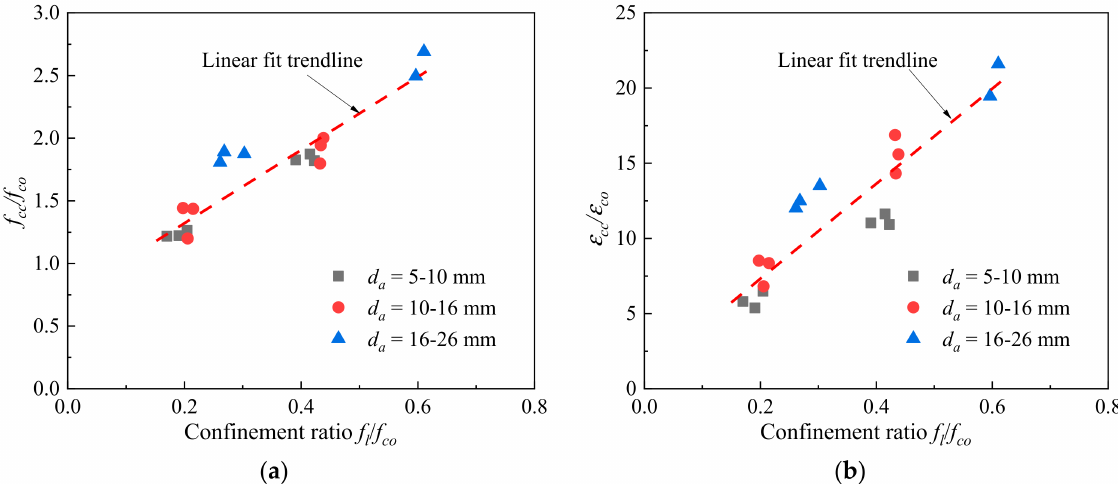
Figure 10. The strength enhancement ratio–confinement ratio relation and strain enhancement ratio–confinement ratio relation. ( a ) Ultimate strength enhancement ratio. ( b ) Ultimate strain enhancement